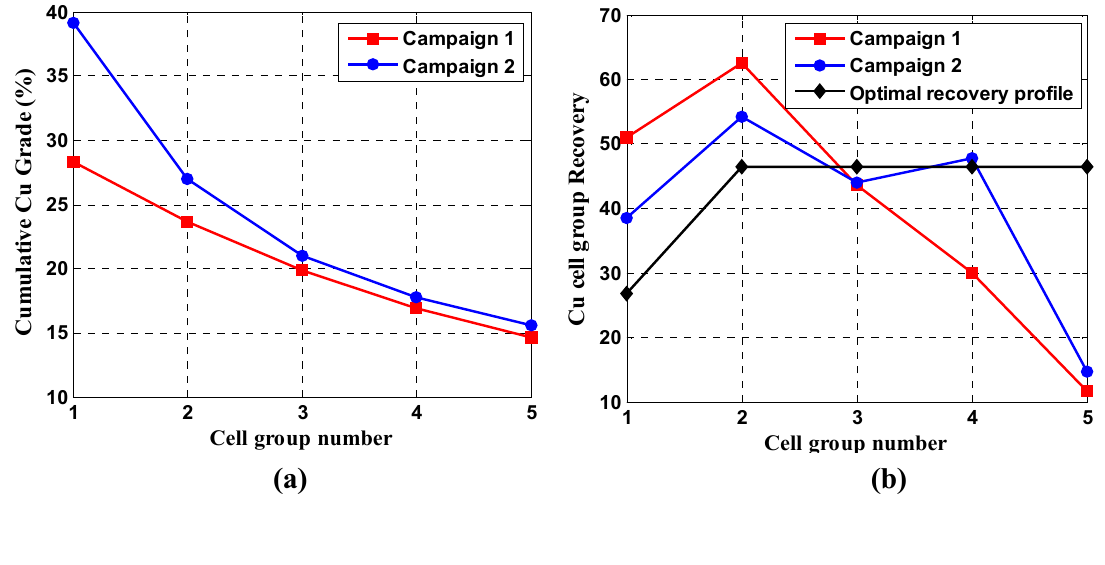
Figure 11. ( a ) Flotation cumulative Cu concentrate grade profiles for two sampling campaigns; ( b ) Corresponding bank-by-bank recovery profiles and optimal bank recovery